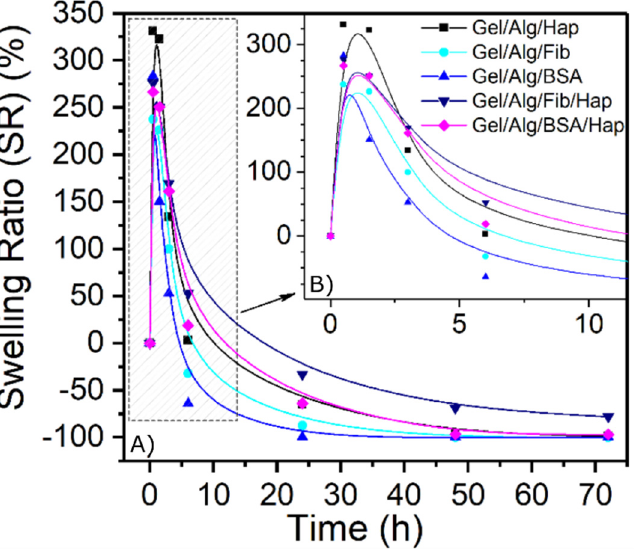
Figure 5. ( A ) Swelling behavior over time. ( B ) Close-up of the first 10 h of swelling.